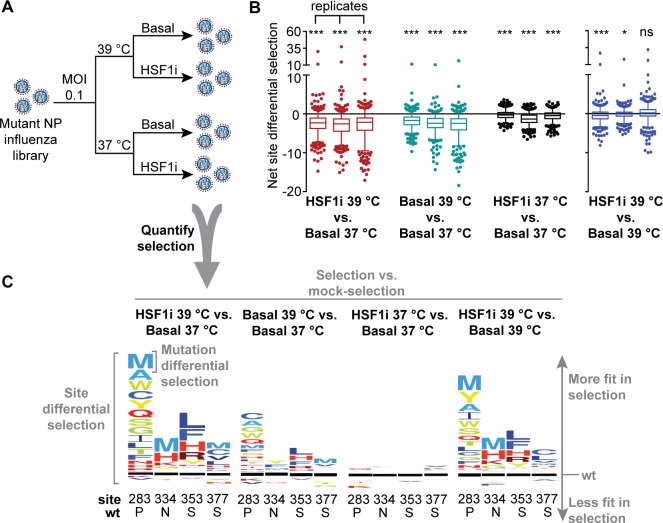
Deep mutational scanning reveals positively selected sites upon chaperone depletion at a biophysically restrictive temperature.(A) Deep mutational scanning selection scheme: each mutant NP influenza library was subjected to selection at 37°C and 39°C in both basal and chaperone-depleted (HSF1i) cells at an MOI of 0.1 virions/cell. Libraries were deep sequenced following replication to quantify the selection on each mutant in the library. Mutation differential selection corresponds to the differential selection of a specific NP mutant, relative to wt NP. Site differential selection corresponds to the sum of the mutation differential selection values for all variants at a given NP site. (B) Box plots showing the distributions of net site differential selection in both basal and chaperone-depleted (HSF1i) cells at 37°C and 39°C. Each selection was performed in biological triplicate; box plots are shown for each replicate. The whiskers show 5th and 95th percentiles, boxes show 25th and 75th percentiles, line shows median value, and points show outliers. The significance of deviation of the mean from zero (no selection) was evaluated by a one-sample t test; * and *** indicate FDRs < 0.05 and < 0.0001, respectively. Nested ANOVA accounting for replicates and treatment conditions was performed for all selection conditions normalized to Basal 37°C (p = 0.0031). For pairwise statistical comparisons, p-values are provided in the statistics section of the Methods. Site differential selection values are provided in S3 Data. (C) Representative sequence logo plots showing amino acid variants at select sites differentially selected upon relative to wt. The size of the amino acid letters corresponds to the magnitude of the mutational differential selection, which is on the same scale for each selection. Amino acids above the black line are more fit in the selection condition compared to the mock-selection condition, amino acids below are less fit, and the black line represents behavior of the wt amino acid in the selection condition. ANOVA, analysis of variance; FDR, false discovery rate; HSF1i, condition in which heat shock factor 1 was inhibited; MOI, multiplicity of infection; NP, nucleoprotein; ns, not significant; wt, wild type.